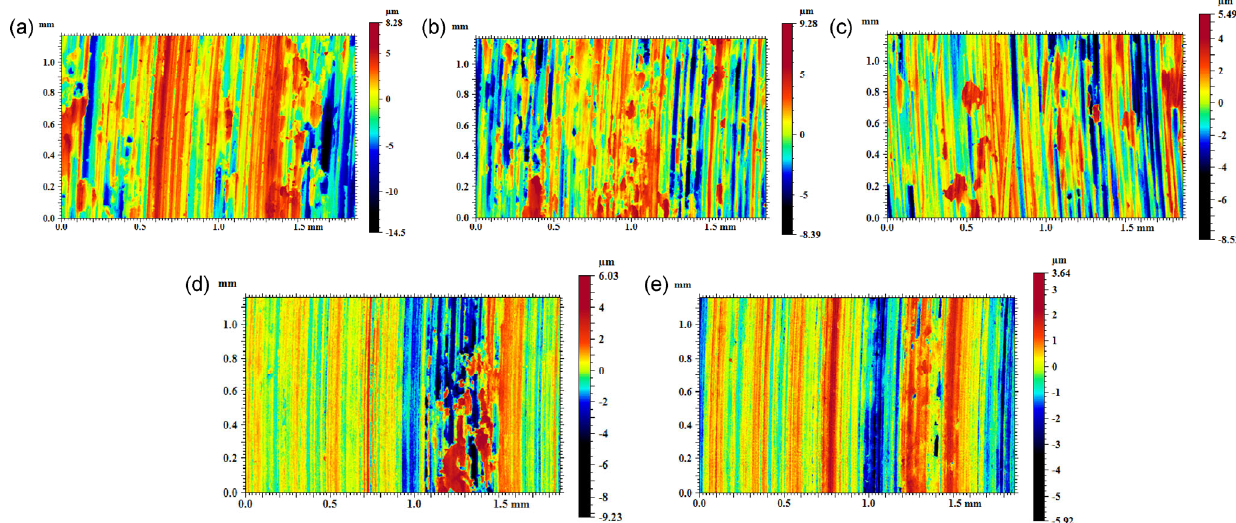
Fig. 13 Surface maps of flat pin (AISI 304) during friction tests after different sliding time: (a) 1 min, (b) 2 min, (c) 3 min, (d) 4 min, and (e) 5